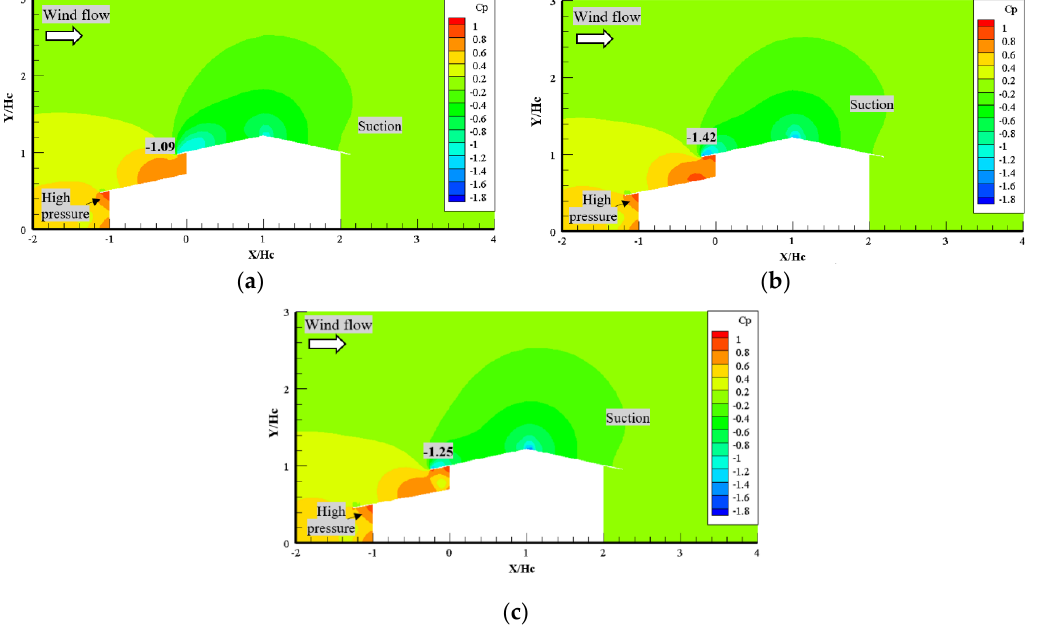
Figure 18. The pressure coefficient contours with an overhang length of ( a ) 0.5 m; ( b ) 0.75 m; and ( c ) 1.0 m.